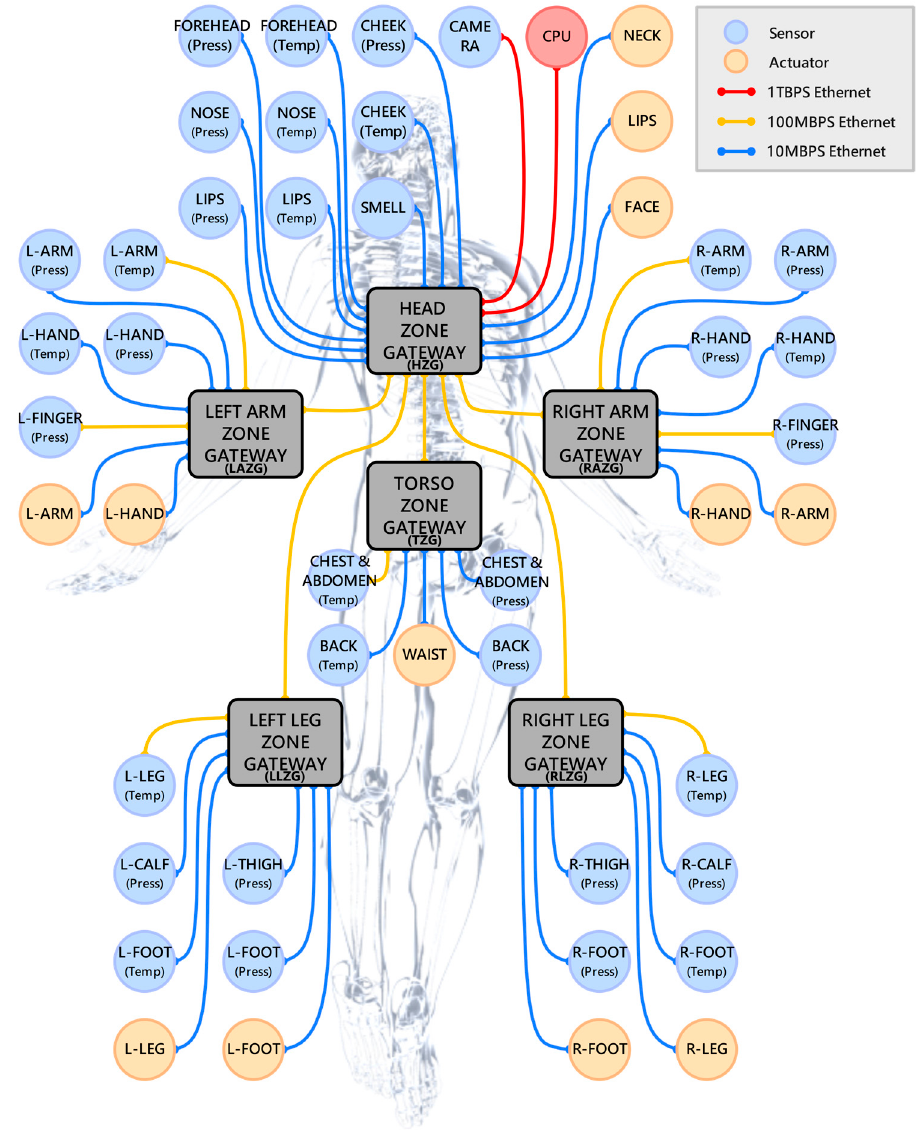
Figure 4. Body structure of zonal IRN architecture. The network is physically divided into six zones: head zone, left arm zone, right arm zone, torso zone, left leg zone, and right leg zone.